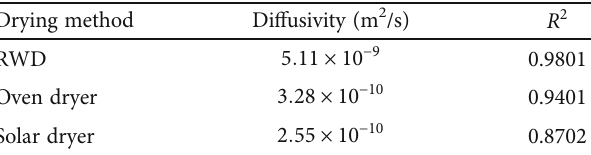
Figure 9: A plot of ln MR and time of jackfruit dried with a solar dryer. Table 4: Di ff usivities of jackfruit slices with di ff erent drying